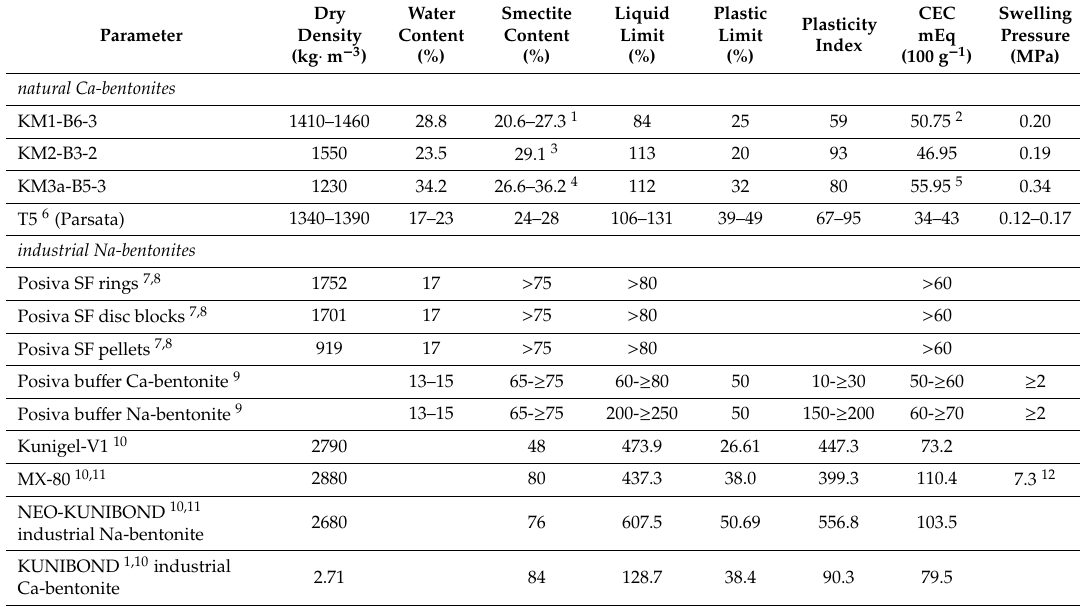
Table 4. Values for some selected physical parameters of the Kato Moni natural bentonite compared with other natural bentonites from Parsata in Cyprus and example industrial bentonites from the Finnish SF programme (values at emplacement in the repository).